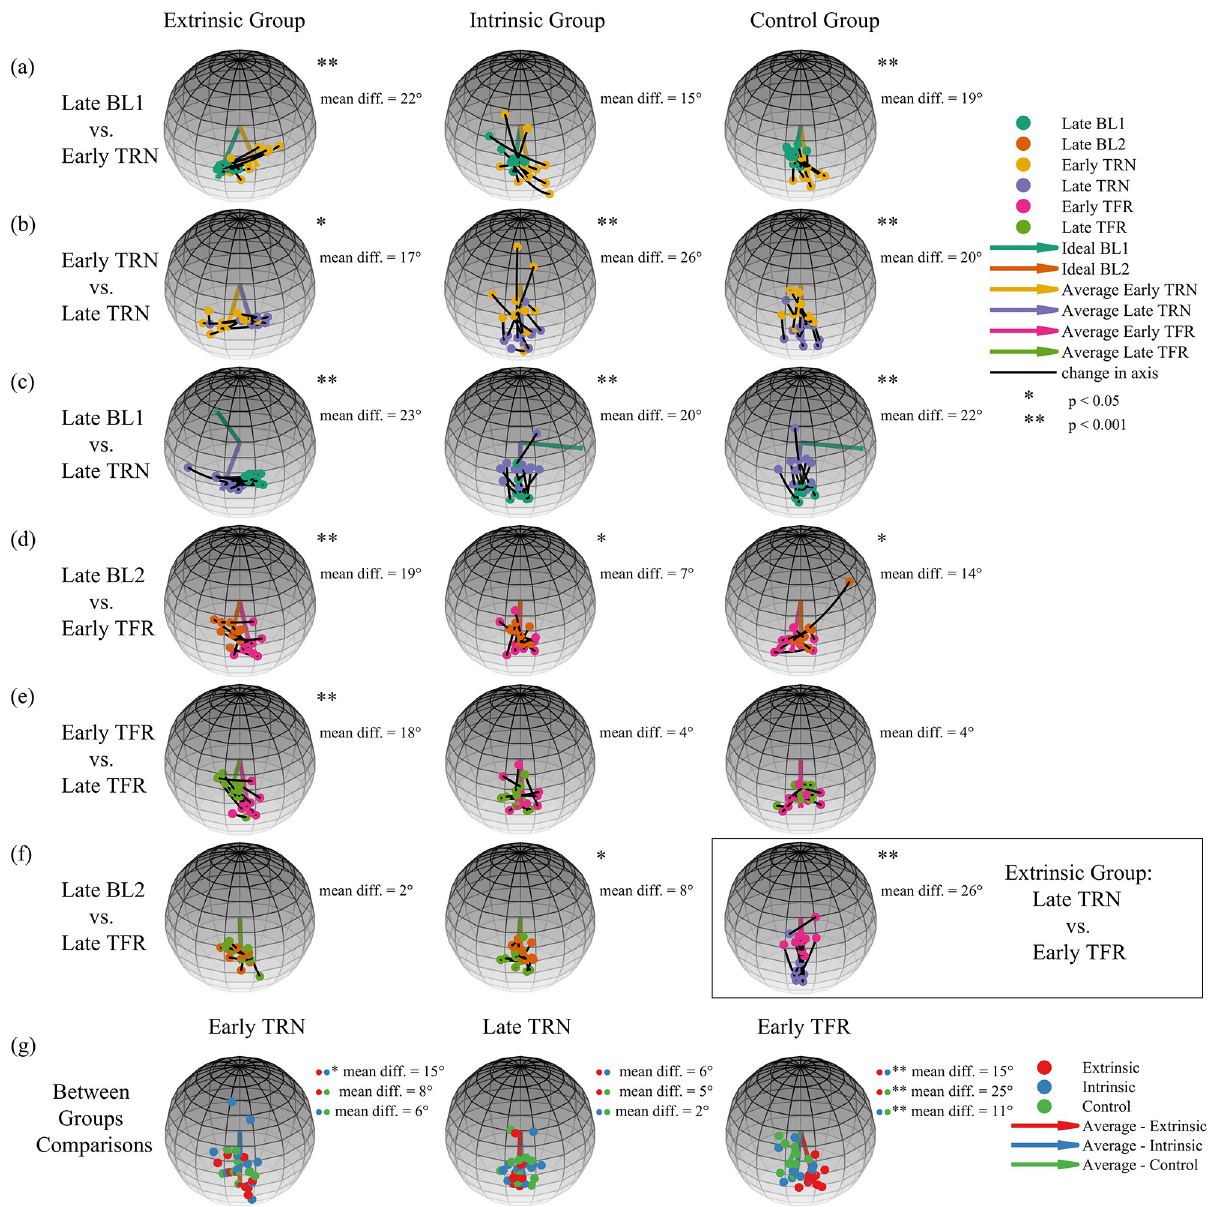
Fig 9. Within and between groups spherical analysis. The spheres show the comparisons of the three-trials analysis within groups between key stages (a)-(f), and between groups within key stages (g). The dots show the average axis of each participant, and the arrows depict either the mean of the sample or the ideal axis (see legend). The view of each sphere was adjusted for visibility. The within group analysis shows an effect of the initial exposure to the perturbation which may stem from correction attempts or from using the three-trials analysis (a). Furthermore, it shows a clear adaptation throughout the TRN session (b)-(c) and a transfer of adaptation only in the Extrinsic group (d), which is washed out by the end of the TFR session (e, left)-(f, left). However, the transfer is only partial (f, right). The between group analysis shows a large difference in the initial exposure to the perturbation between the Extrinsic group and both the Intrinsic and control groups (g, left). It also shows no difference in the late TRN axes, indicating similar adaptation patterns (g, middle). Most importantly, it highlights the difference in the early TFR stage between the Extrinsic and Intrinsic groups (g,